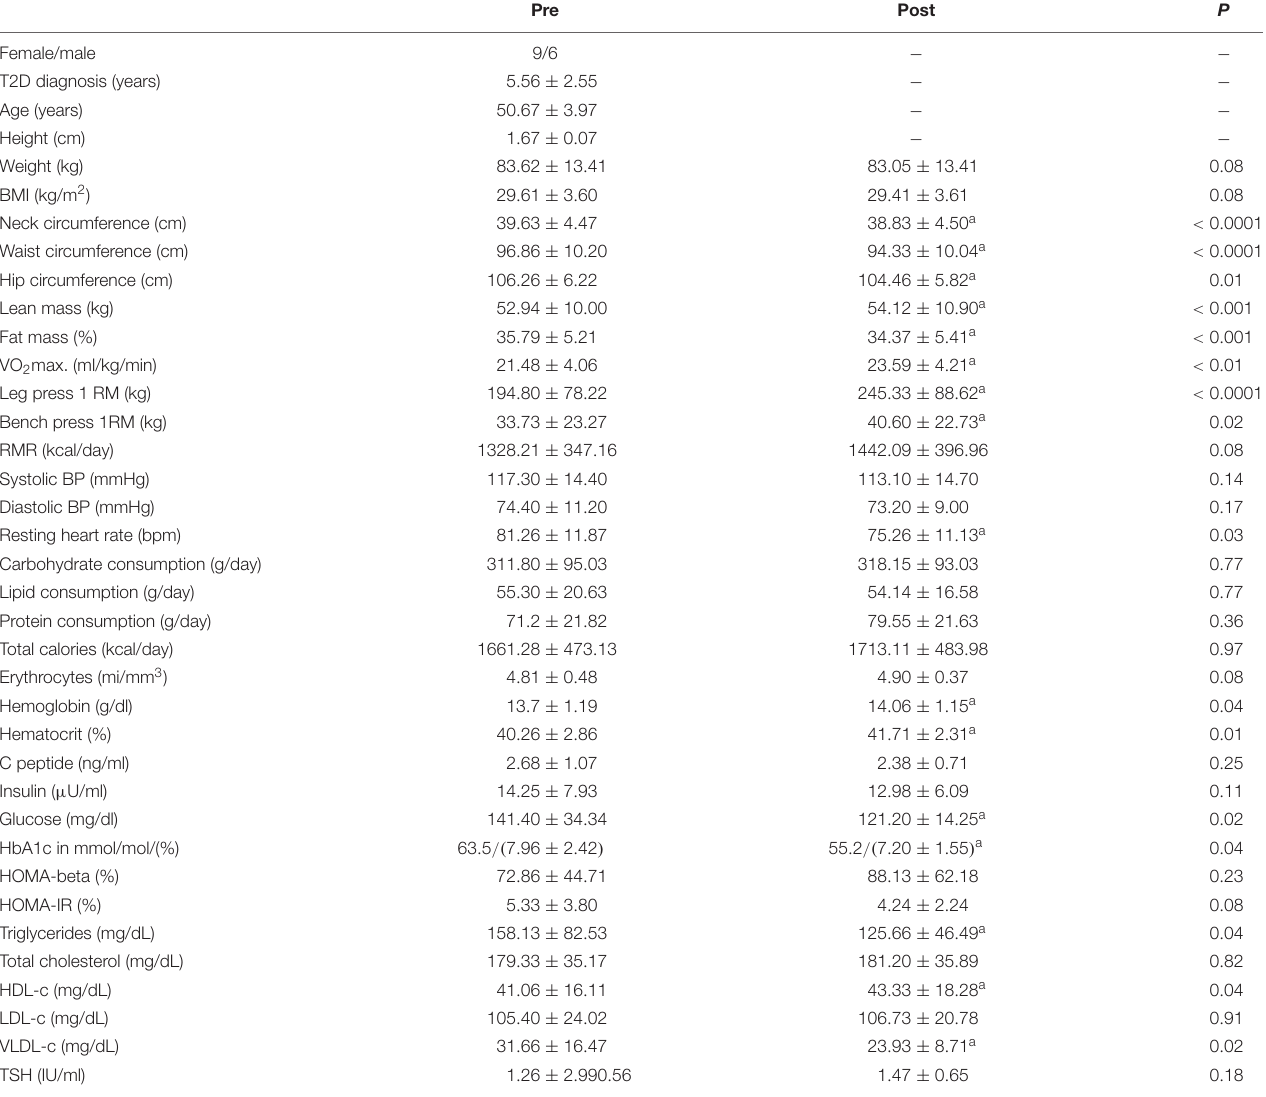
TABLE 2 | Clinical parameters of